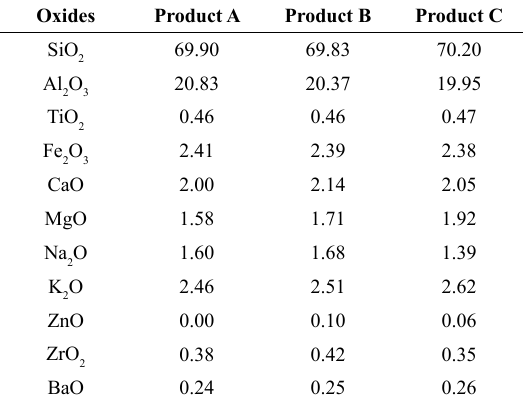
Table 2. Chemical analysis (wt%) of the investigated samples.